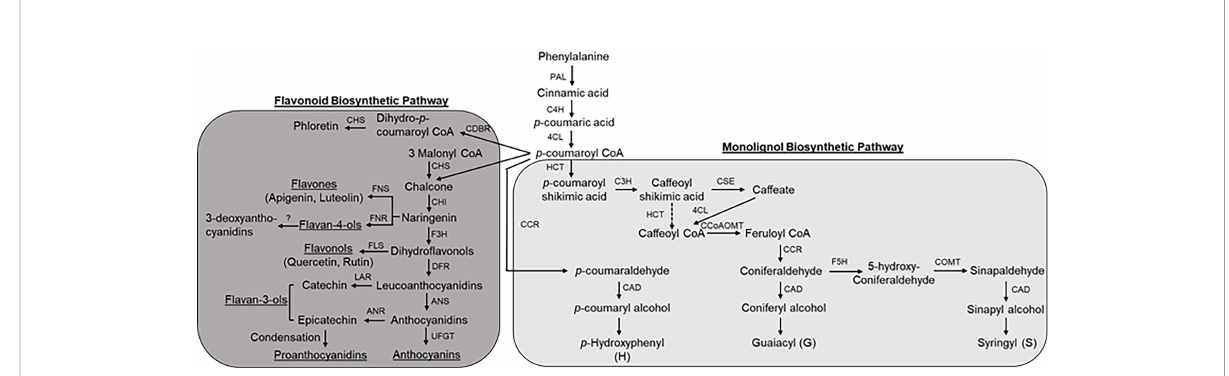
FIGURE 2 Schematic representation of phenylpropanoid pathway in sorghum (modi fi ed from Scully et al., 2016). Enzyme abbreviations: PAL, phenylalanine ammonia lyase; C4H, cinnamate 4-hydroxylase; 4CL, 4-coumarate:CoA ligase; HCT, p -hydroxycinnamoyltransferase; C3H, 4-coumarate hydroxylase; CSE, caffeoyl shikimate esterase; CCoAOMT, caffeoyl-CoA- O -methyltransferase; CCR, cinnamoyl-CoA reductase; F5H, ferulate 5-hydroxylase; COMT, caffeic acid O -methyl transferase; CAD, cinnamyl alcohol dehydrogenase; CHS, chalcone synthase; CHI, chalcone isomerase; FNS, fl avone synthase; F3H, fl avanone 3-hydroxylase; FLS, fl avonol synthasae; DFR, dihydro fl avonol 4-reductase; LAR, leucoanthocyanidin reductase; ANS, anthocyanidin synthase; ANR, anthocyanidin reductase; UFGT, UDP-glucose: fl avonoid